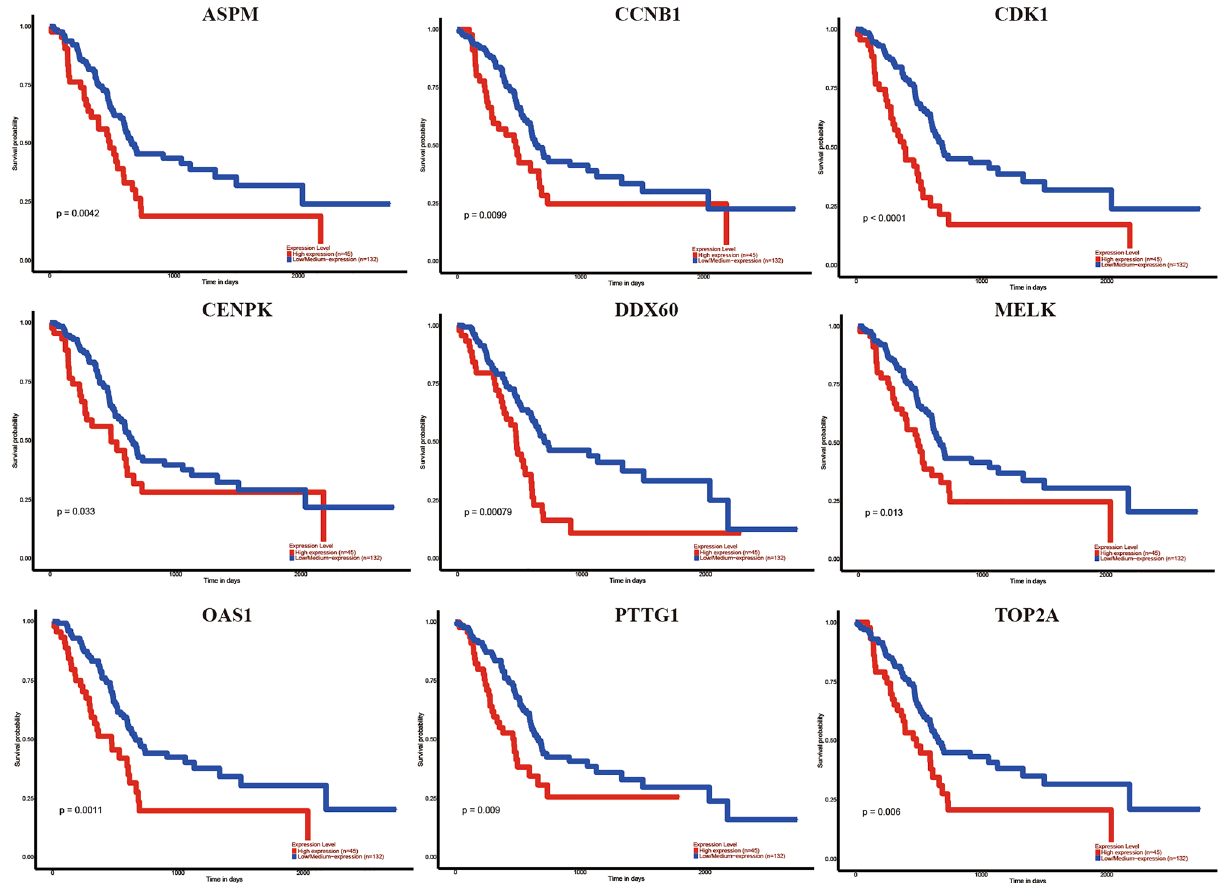
Figure 7. Analysis of correlation between the expression of central genes and the overall survival of PDAC patients via